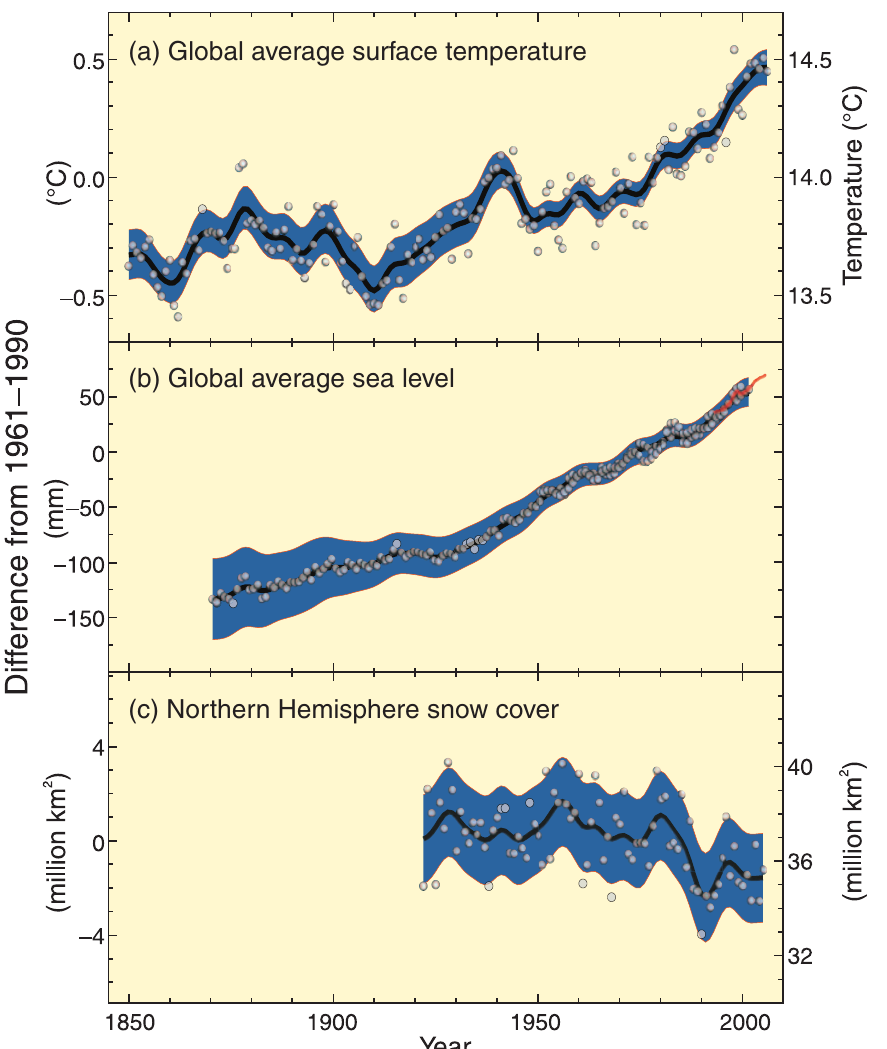
Figure SPM.1. Observed changes in (a) global average surface temperature; (b) global average sea level from tide gauge (blue) and satellite (red) data and (c) Northern Hemisphere snow cover for March-April. All differences are relative to corresponding averages for the period 1961- 1990. Smoothed curves represent decadal averaged values while circles show yearly values. The shaded areas are the uncertainty intervals estimated from a comprehensive analysis of known uncertainties (a and b) and from the time series (c). {Figure